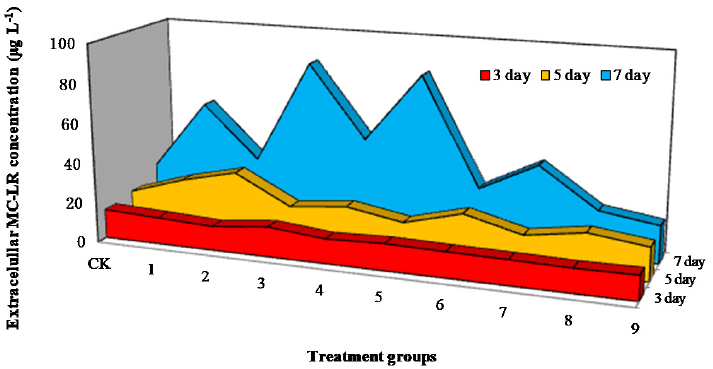
Figure 3. Influence of mixed allelochemicals on the extracellular microcystin leucine arginine (MC-LR) concentration in each sample group.